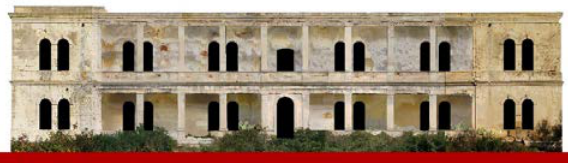
Figure 10. South facade of official barracks